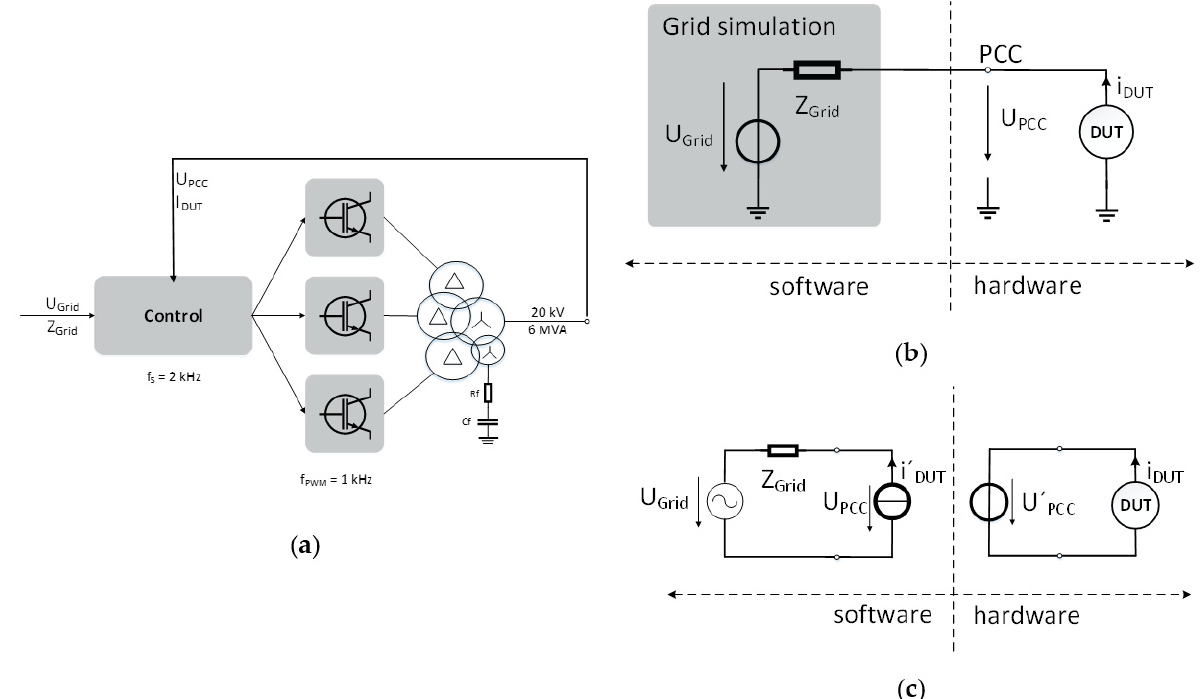
Figure 3. Overall power-level HiL Control Concept [36]. ( a ) Impedance control implementation as part of the grid emulator, ( b ) Single-phase equivalent circuit, and ( c ) PHiL implementation using an ITM interface algorithm.